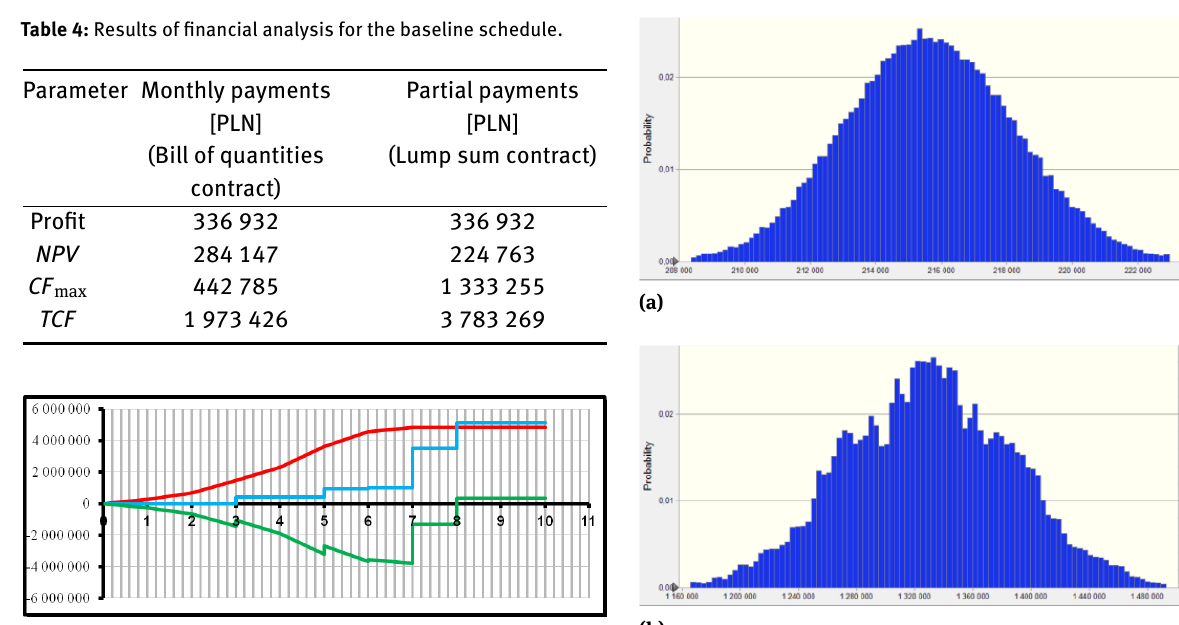
Figure 5: Contractor’s cumulative expenditures, client’s cumulative payments and contractor’s cumulative cash flow in case of bill of quantities contract; based upon data given in TTable 3 and Figure 3.